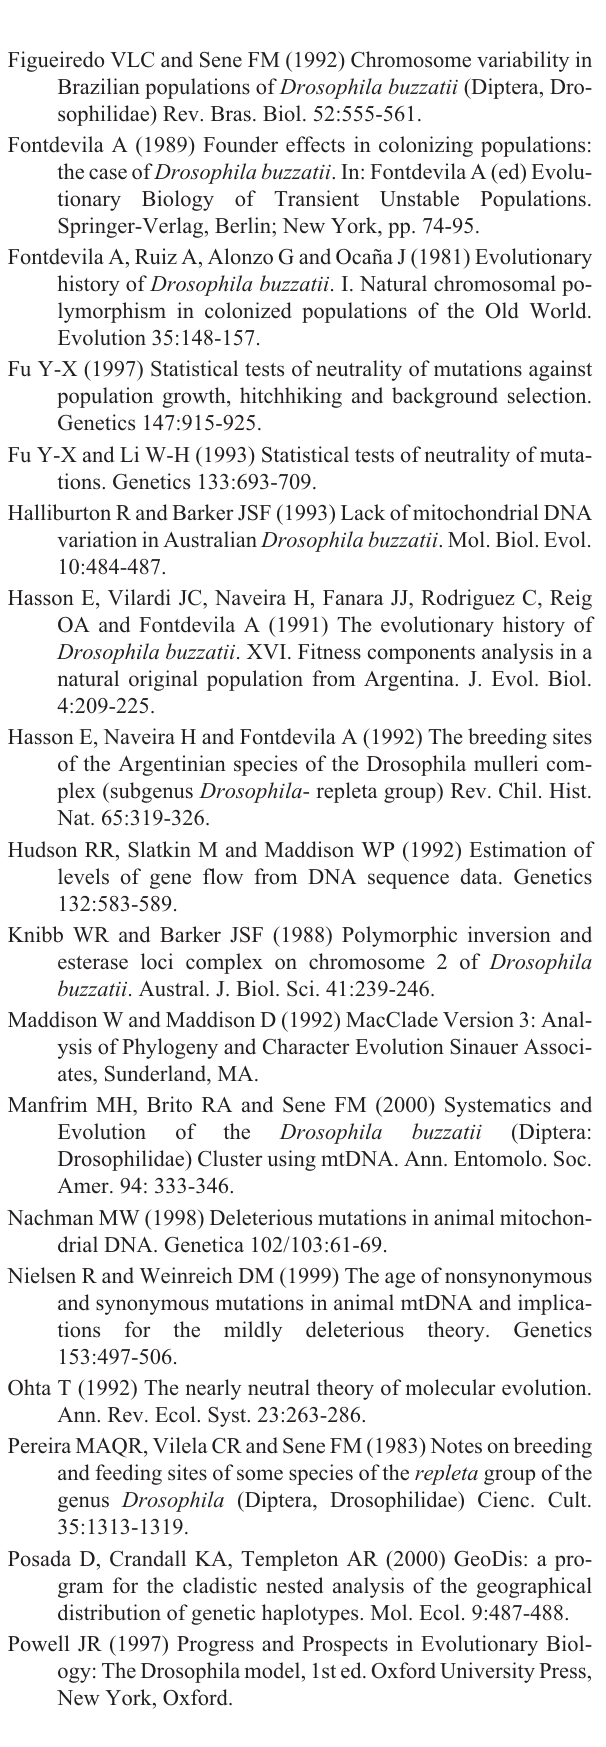
Figueiredo VLC and Sene FM (1992) Chromosome variability in Brazilian populations of Drosophila buzzatii (Diptera, Dro- sophilidae) Rev. Bras. Biol.